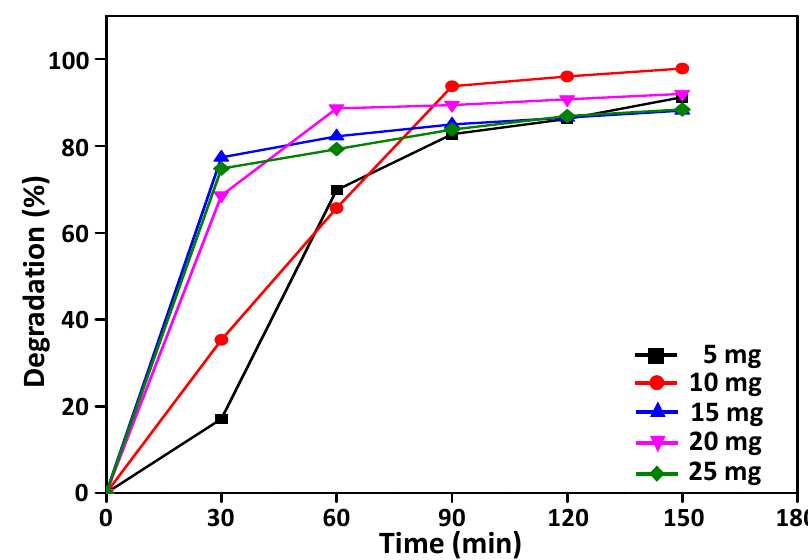
Figure 10. Degradation of MB with varying catalyst loads (B1) and constant dye concentration.